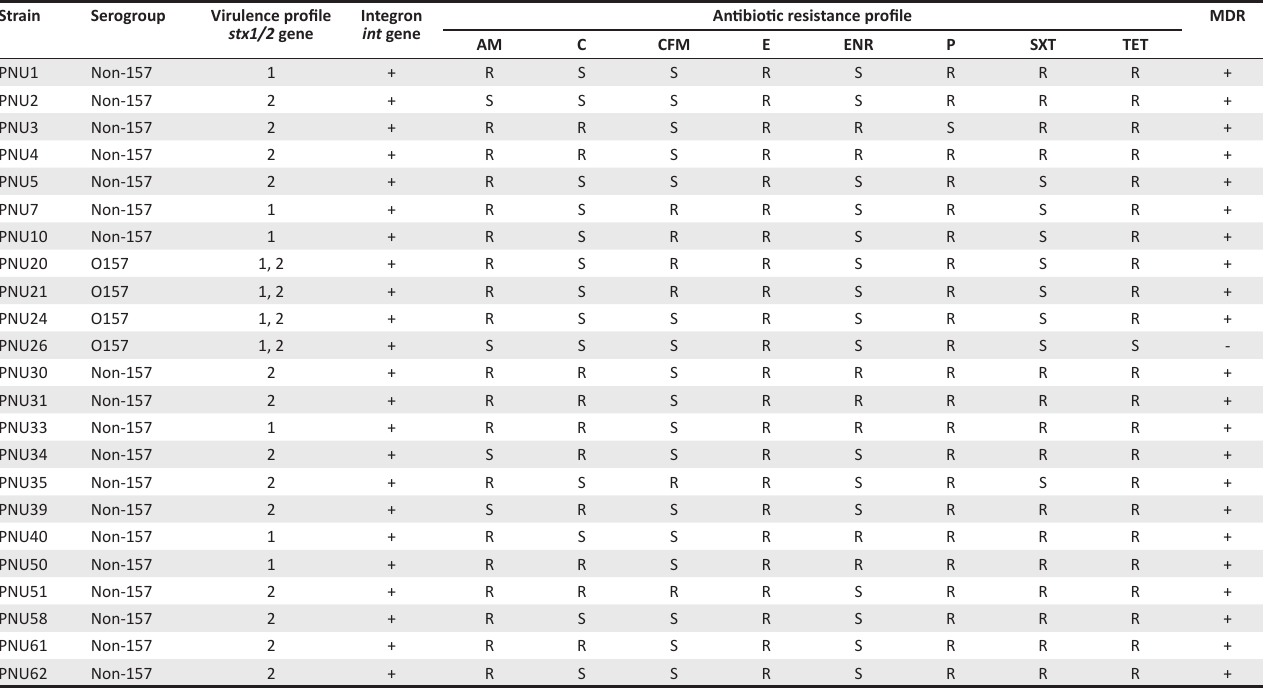
TABLE 4: Overview of the integron-positive Shiga toxin–producing Escherichia coli strains. Strain Serogroup